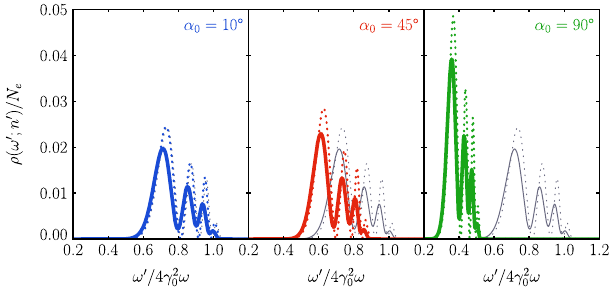
FIG. 3. Dependence of the warm spectral density (thick solid curves) on the scaled photon frequency for different electron angles of incidence (cid:6) 0 ¼ 10 (cid:9) , 45 (cid:9) , and 90 (cid:9) . The spectrum is observed in the direction of the primary electron bunch n 0 k u 0 , i.e. (cid:3) ¼ (cid:6) 0 and (cid:4) ¼ ’ 0 . For comparison, the respective cold spectral densities are also shown as colored dotted lines. To guide the eye, the results for (cid:6) 0 ¼ 0 (cid:9) are also shown in each panel as thin gray solid and dotted curves. Parameters are a 0 ¼ 1 : 0 , (cid:9) ¼ 18 , ! ¼ 1 : 5 eV , m(cid:2) 0 ¼ 40 MeV , (cid:5) (cid:2)=(cid:2) 0 ¼ 10 (cid:1) 3 , and (cid:5) (cid:6) ¼ 1 : 75 mrad